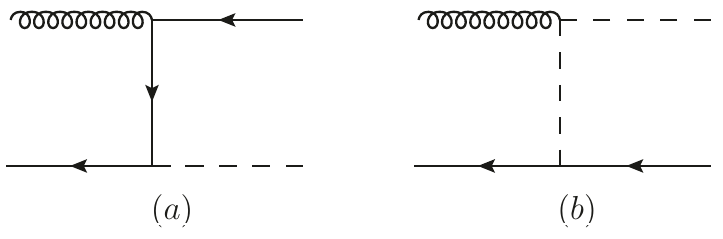
Figure 6 . Diagrams for the process q + ‘ → g + LQ contributing to the resonant leptoquark production at O ( α s ) .